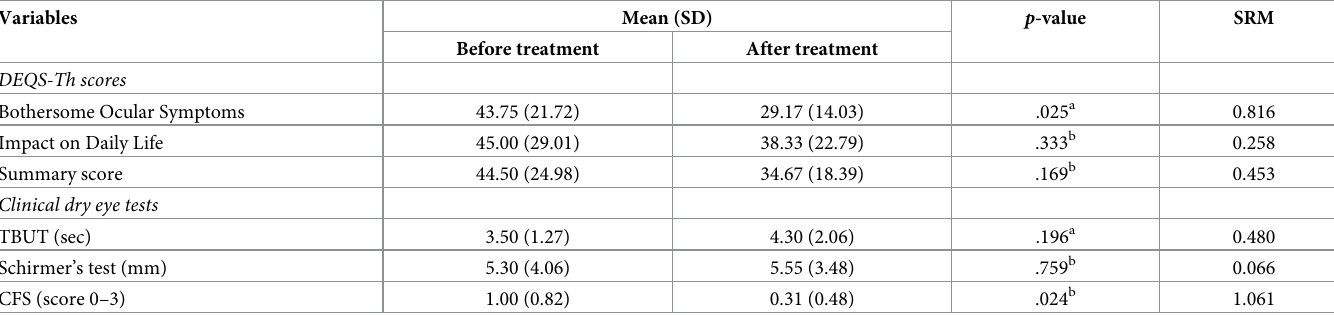
DEQS-Th, the Thai version of the Dry Eye-Related Quality-of-Life Score; TBUT, tear break-up time; CFS, corneal fluorescein staining; SRM, standardized response mean. a An Independent Samples t-test was used for statistical comparisons b The Wilcoxon Signed Ranks test was used for statistical comparisons.